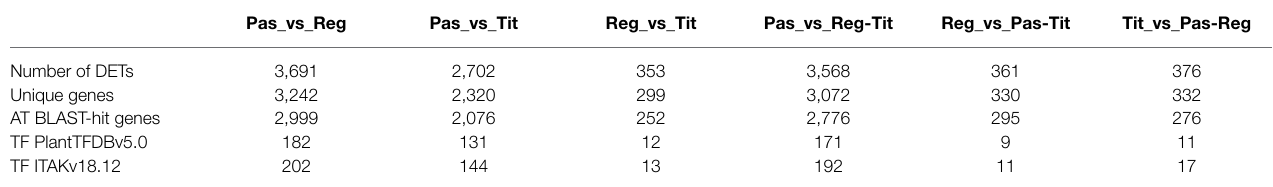
TABLE 1 | Intersecting DETs with threshold FDR < 1e-2 and log2FC is set to 1 from pairwise comparisons of quinoa seed transcriptomes between genotypes (one to one; column 2–4, or one to two; column